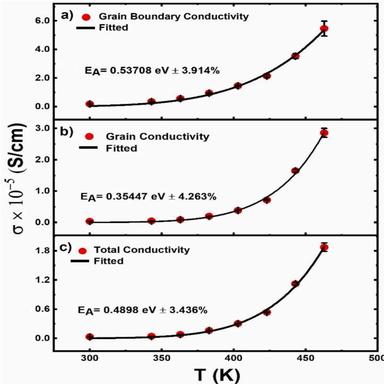
The activation energy from a) grain boundary conductivity (σgb), b) grain conductivity (σg) and c) total conductivity (σt).